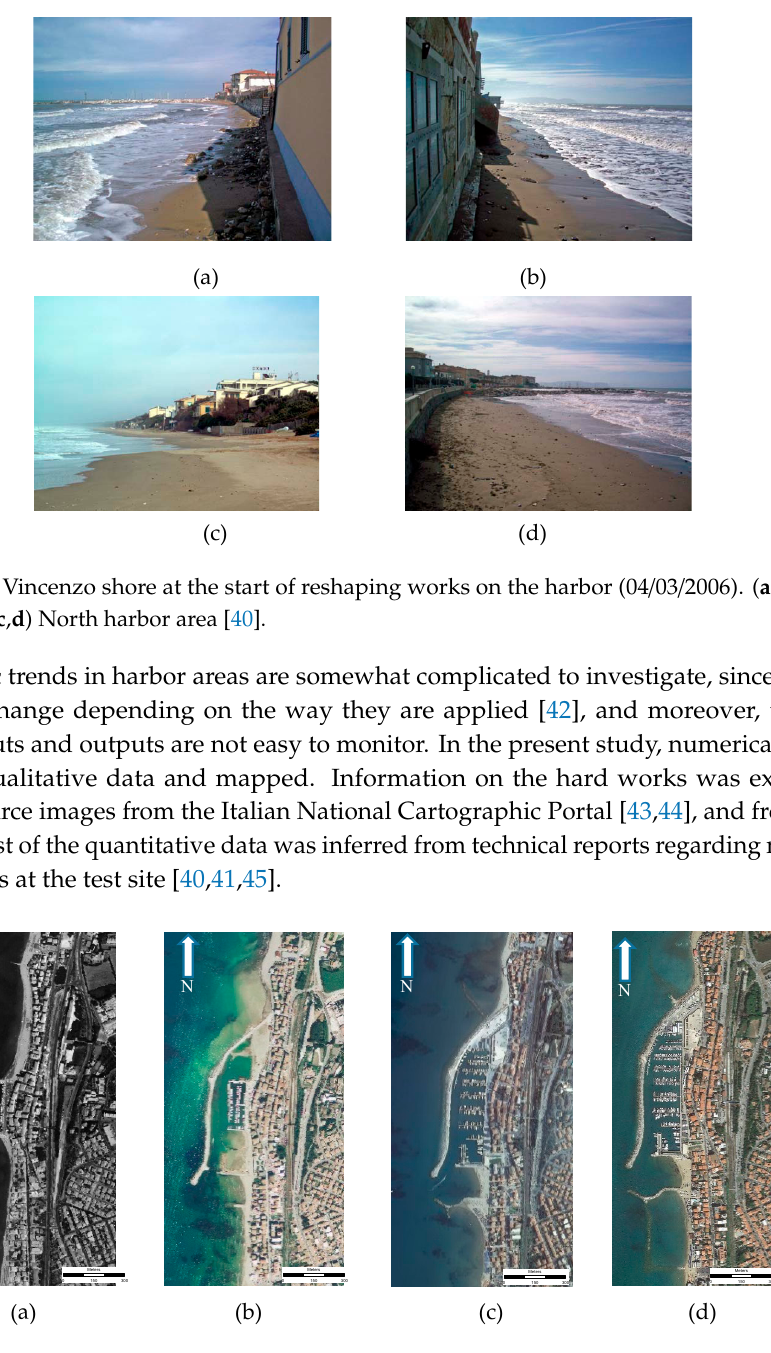
(c) Figure 3. San Vincenzo’s subunit partition; (a) North Harbor Sub Unit; (b) South Harbor Sub Unit; (c)